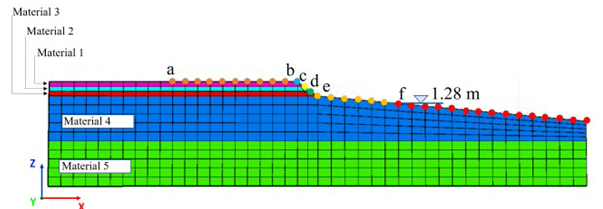
Figure 19. Model monitoring